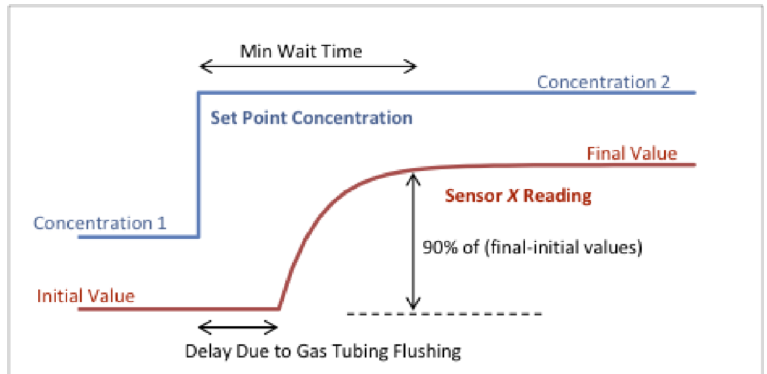
Figure 7. Sensor response following the set point concentration of the target gas sent to the mass flow controller (MFC).